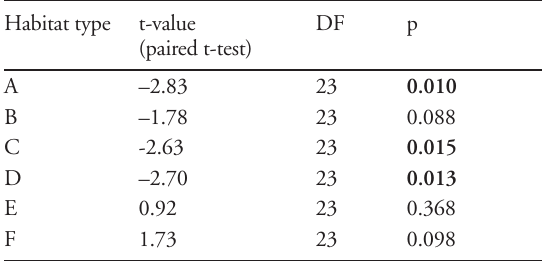
Table 2. Results of paired t-test for determining the significance of interseasonal differences in the relative abundance of the vari- ous amphibian species by habitat type. Significant values are re- ported in boldface. DF = degrees of